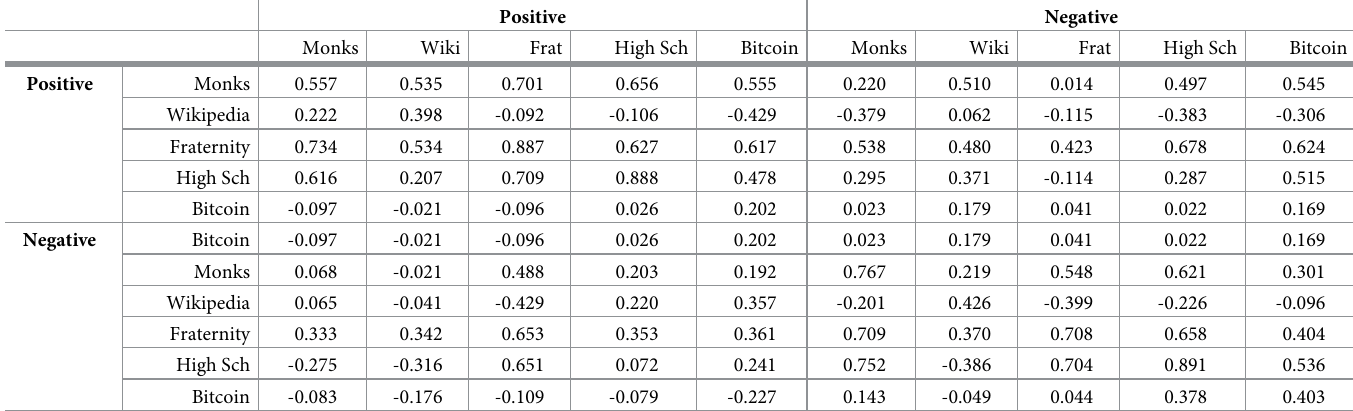
Table 2. Average correlation coefficient between networks’ predicted probabilities by genre and positive versus negative sentiment.